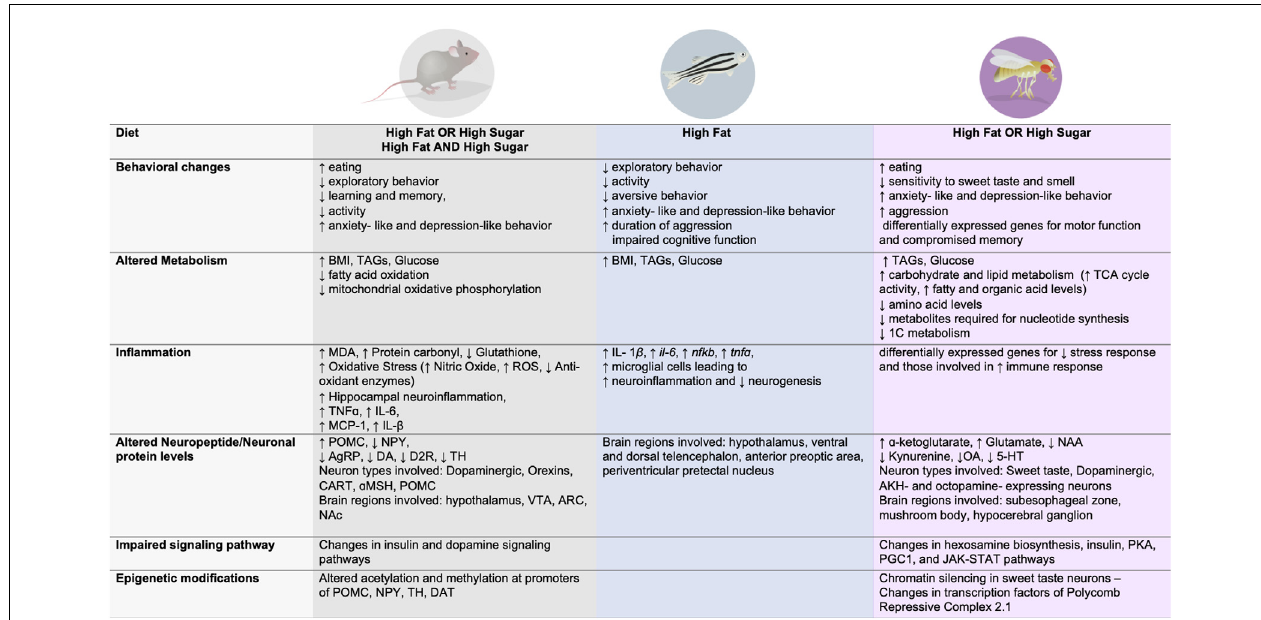
FIGURE 2 | Dietary effects on behavior, metabolism, immune function, signaling, neuronal changes, and epigenetic modifications across three animal model